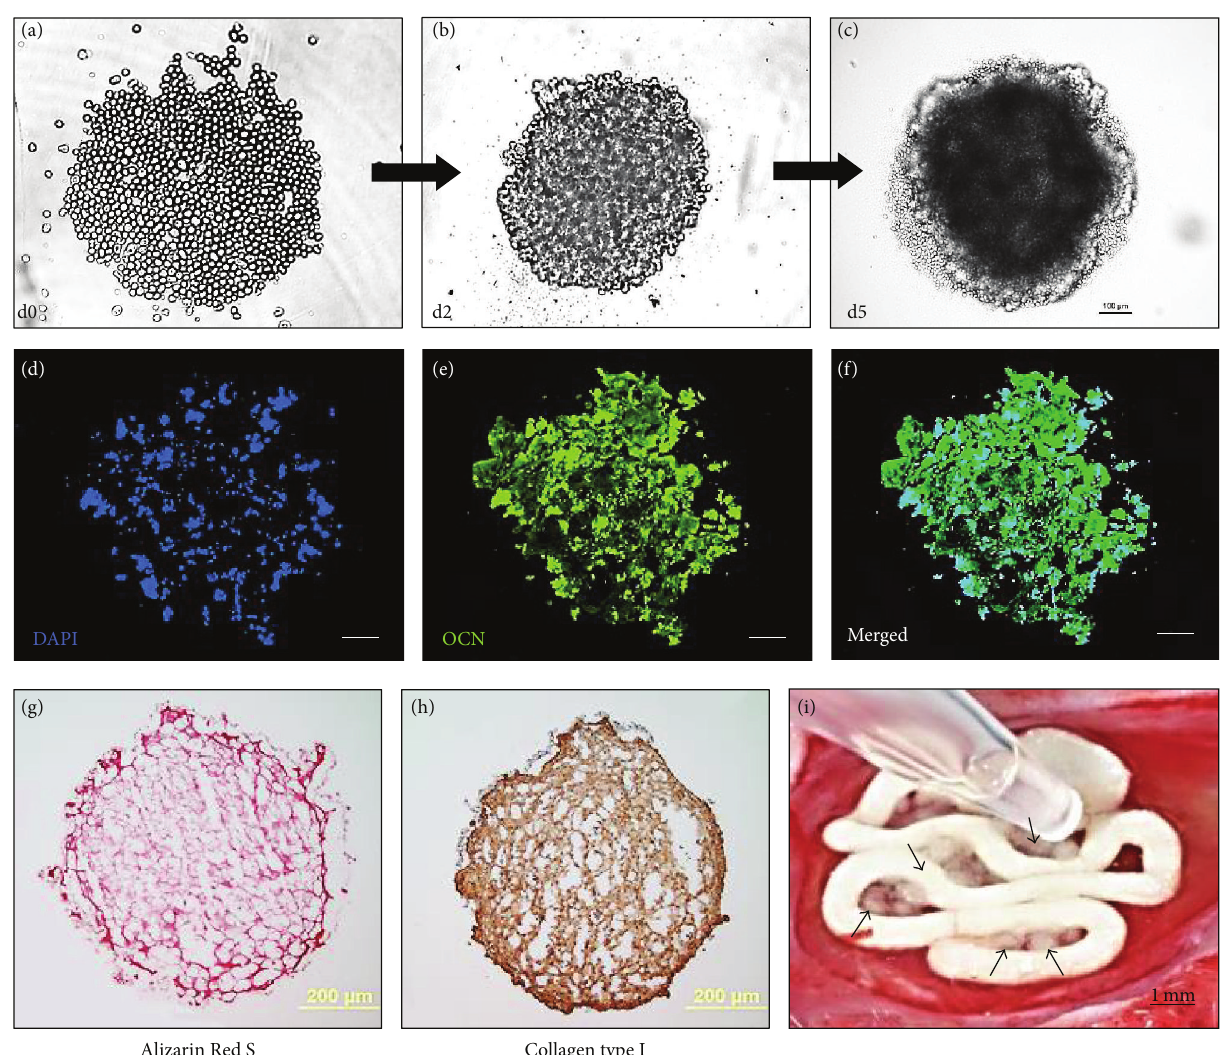
Figure 3: Characterization of osteogenic differentiation of MAPCs in 3D aggregate culture. The generation of MAPC aggregates was observed on 0, 2, and 5 days after suspension culture ((a) to (c)). Cell aggregation formed a compact spheroid at day 5 (c). After 28 days, osteogenic potential of 3D aggregates was analyzed by immunostaining with osteocalcin ((d), (e), and (f)) and collagen type I (h) antibodies. Mineralization was also observed by Alizarin Red S staining (g). (i) showed direct aggregates seeding on the scaffold during surgery on rat calvarial defect (arrows indicate 3D aggregates). Scale bars:100 𝜇 m ((a) to (f)), 200 𝜇 m ((g) and (h)), and 1mm